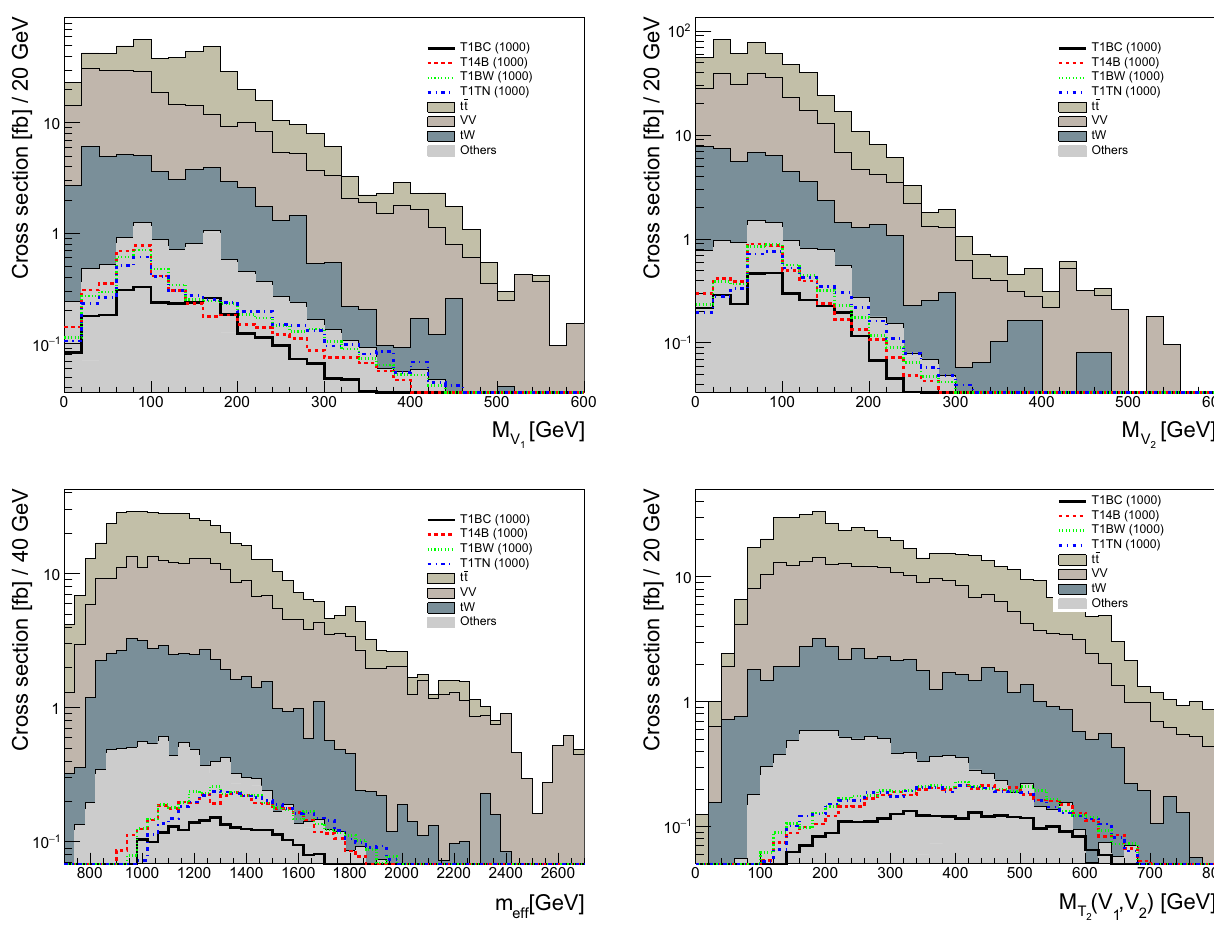
Fig. 4 Kinematic distributions for signals and backgrounds after preselection